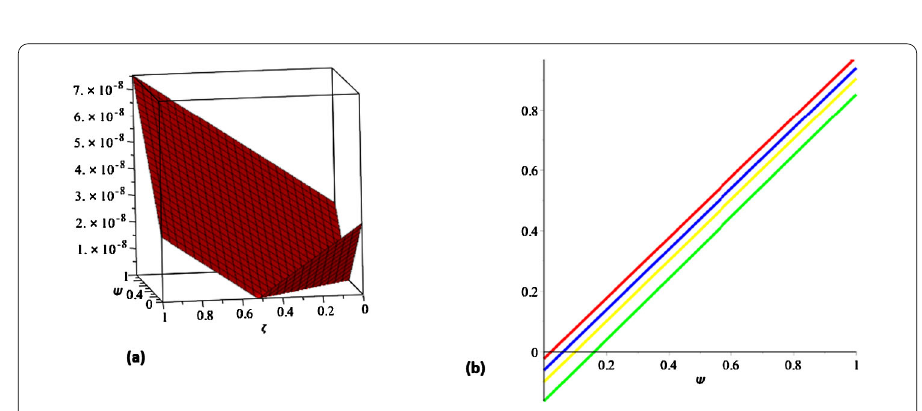
Figure 11 The ETDM ν -solution graph of example 3, ( a ) Error graph and ( b ) at different fractional orders of δ at ζ = 0.5